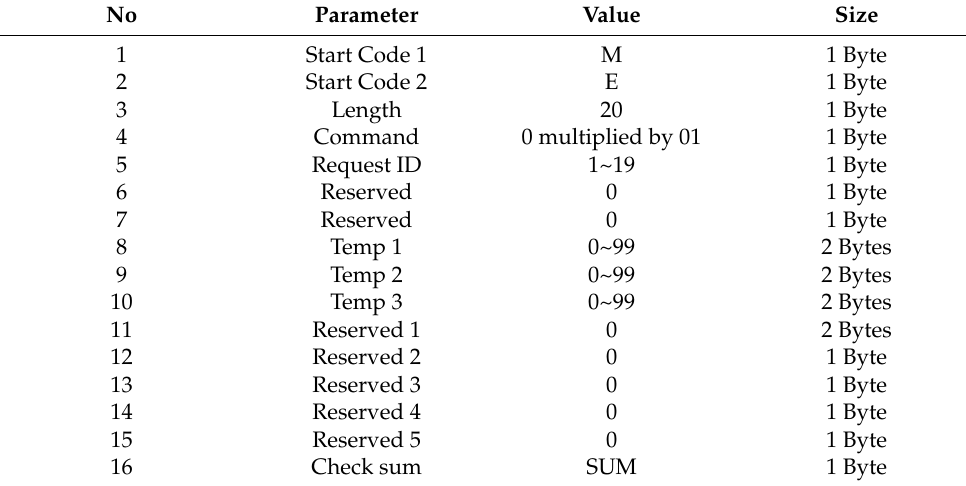
Table 3. Peripheral processor response protocol.